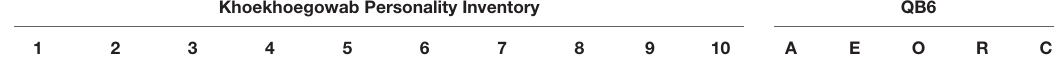
TABLE 3 | Khoekhoegowab Personality Inventory (KPI) and Questionnaire Big Six (QB6) Scale Correlations and Intercorrelations. Khoekhoegowab Personality